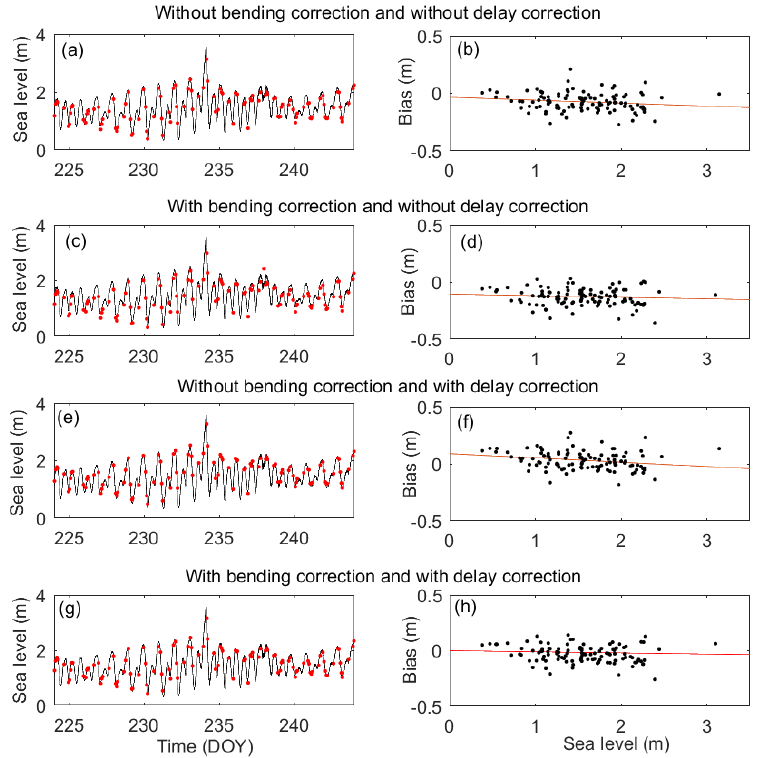
Figure 8. GPS L5 sea-level retrievals with and without bending correction or tropospheric delay correction, and the corresponding biases vs. sea-level measurements for HKQT: ( a ) sea-level retrievals without bending correction and tropospheric delay correction; ( b ) biases of retrievals in ( a ) versus sea-level measurements; ( c ) sea-level retrievals with bending correction and without tropo- spheric delay correction; ( d ) biases of retrievals in ( c ) versus sea-level measurements; ( e ) sea-level retrievals without bending correction and with tropospheric delay correction; ( f ) biases of retrievals in ( e ) versus sea-level measurements; ( g ) sea-level retrievals with bending correction and tropo- spheric delay correction; ( h ) biases of retrievals in ( g ) versus sea-level measurements. In Figure 8b, the retrievals without bending error correction and tropospheric delay error have scale bias and slight average bias. Figure 8d,f show that, with only one correc- tion of the bending error or the tropospheric delay error, retrievals exhibited significant scale or average biases. Figure 8h shows that after the correction of both the bending error and tropospheric delay error, the retrievals exhibited no obvious scale or average biases.